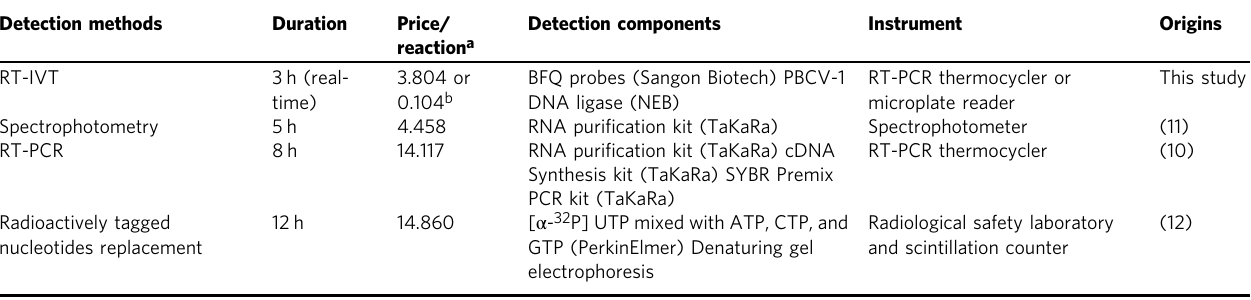
a The cost only applies to the detection components in the reaction and the price was transferred by rate calculation of RMB to USD. b The price of 3.804 was calculated using BFQ probes added to PBCV-1 DNA ligase purchased from New England Biolabs (NEB) corporation, while the price of 0.104 was calculated using BFQ probes added to PBCV-1 DNA ligase puri fi ed in our